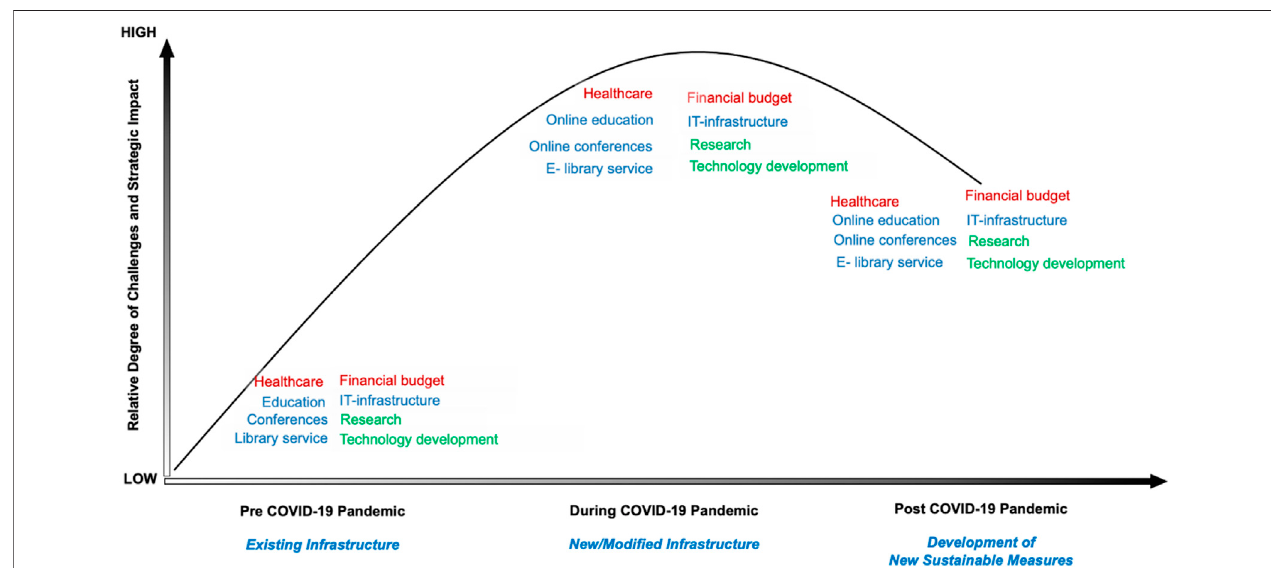
FIGURE 2 | Illustration. The relativedegree of challenges and strategic impact shown as a function of three different time points. The components listed are part of challenges that academic institutions are currently facing during the COVID-19 pandemic. We assume that rapid increase in challenges and strategic impact on these services (and facilities) during the COVID-19 pandemic will require active collateral support from governments and funding agencies which should continue even in the post-COVID-19 pandemic period. The line serves as a visual guide for illustration to display the strategic impact.